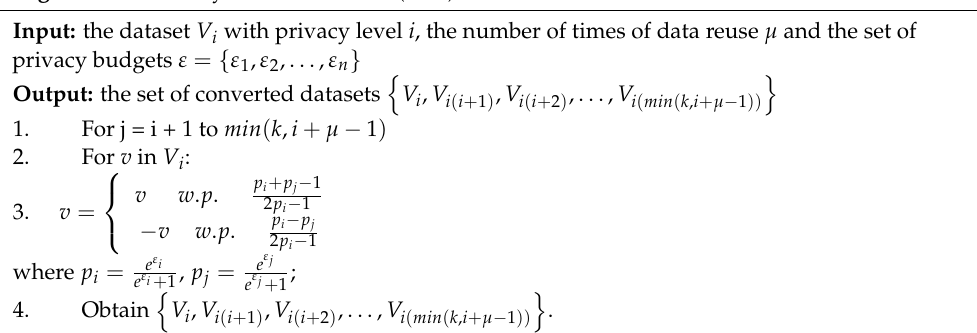
Algorithm 4. Privacy level conversion